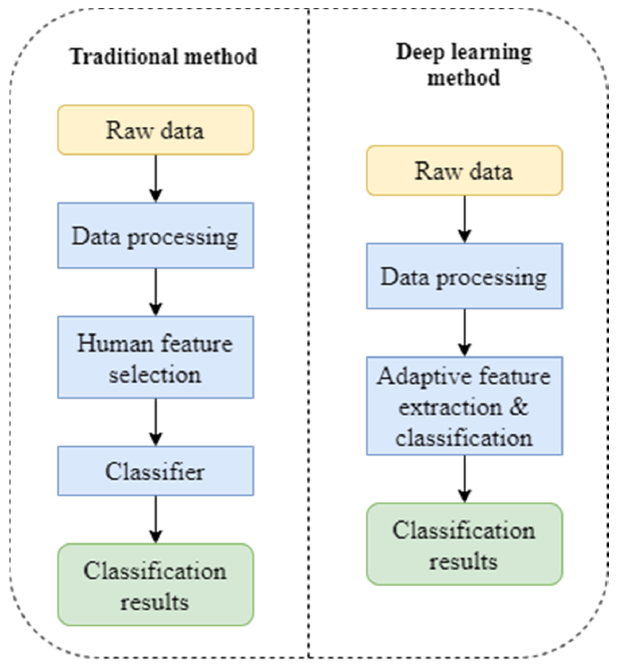
Figure 15. Comparison between traditional fault detection method and deep learning algorithm.